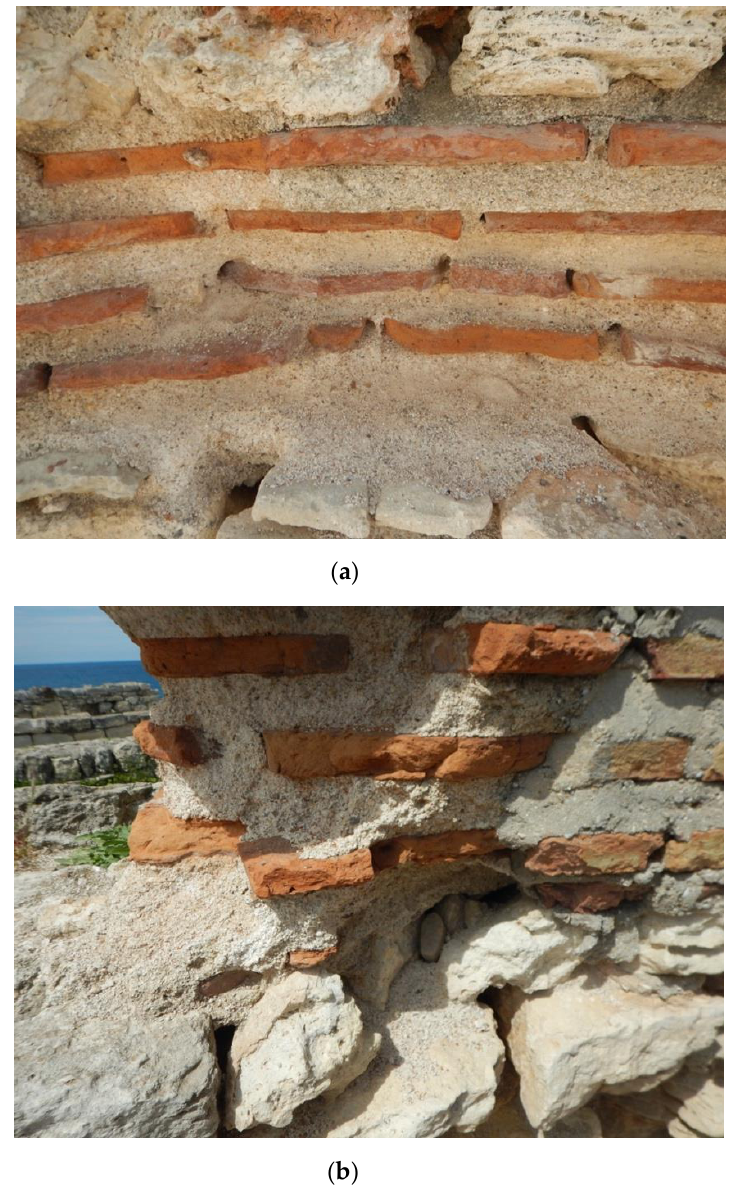
Figure 1. Fragments of brickwork on lime mortar in Chersonesos (Crimea): ( a ) The undestroyed part of the brickwork; ( b ) Destroyed part of brickwork.